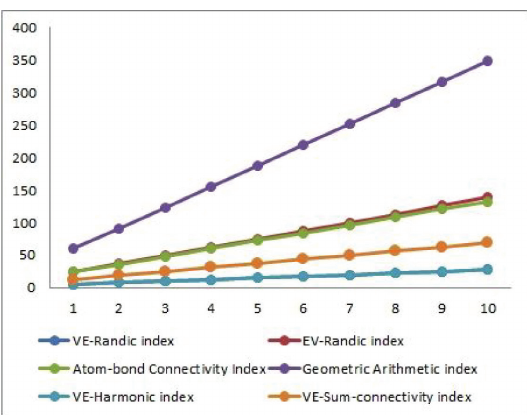
Figure 6: Graphical comparison of , ev ve R GA , ve ABC , ve ve H R , and ve χ for